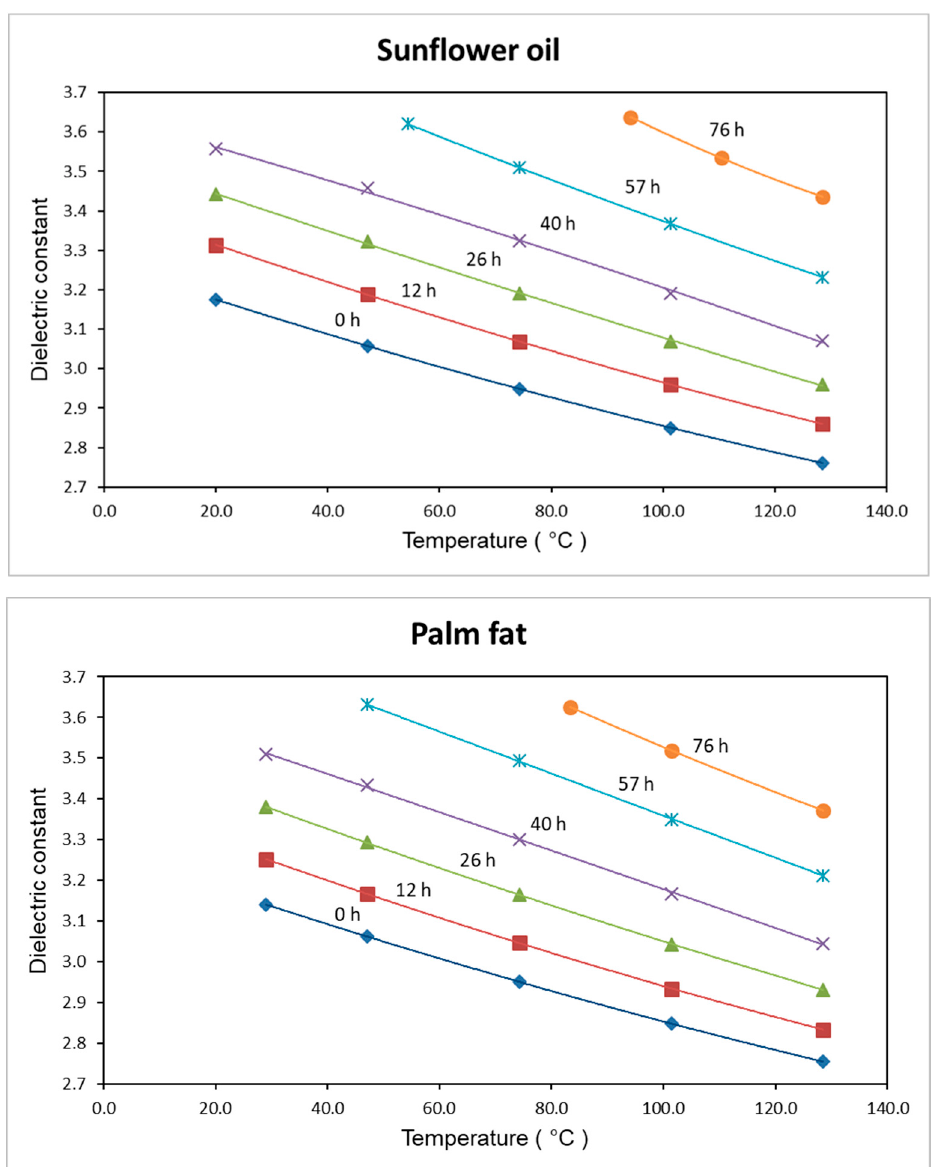
Figure 5. Dielectric constants of thermo-oxidatively treated sunflower oil and palm fat vs. measuring temperature; temperature of thermal treatment: 175 ± 3 °C; parameter: thermal treatment time.